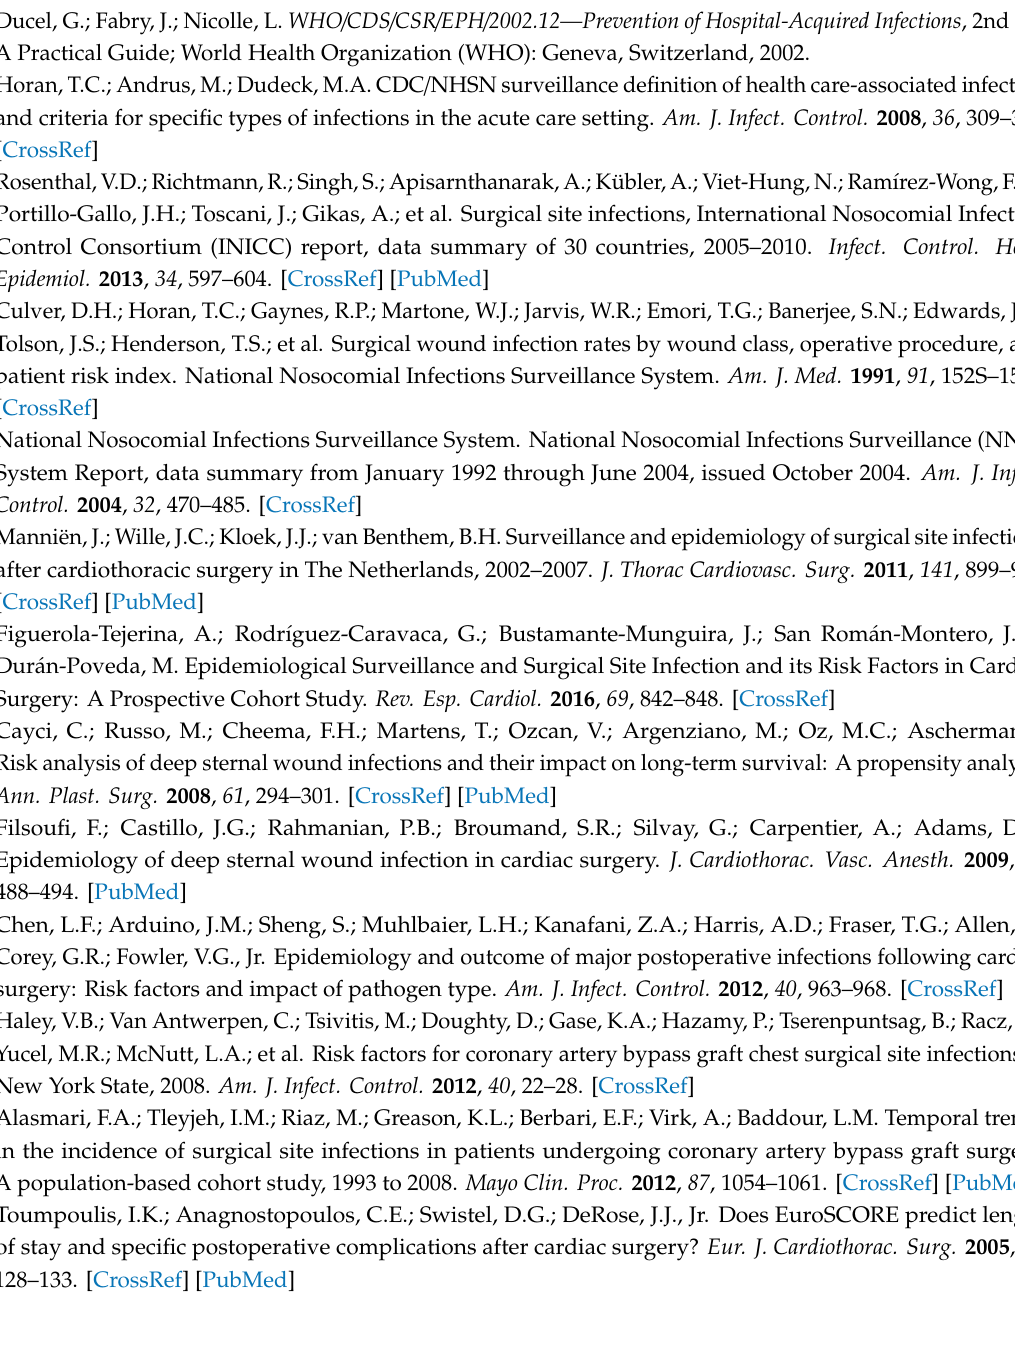
Figure S1: Comparisons of aROC corresponding to IRIC, NISS, EuroSCORE and ACRI to evaluate di ff erences between these scoring systems (test sample), Table S1: Patients in the training and the test